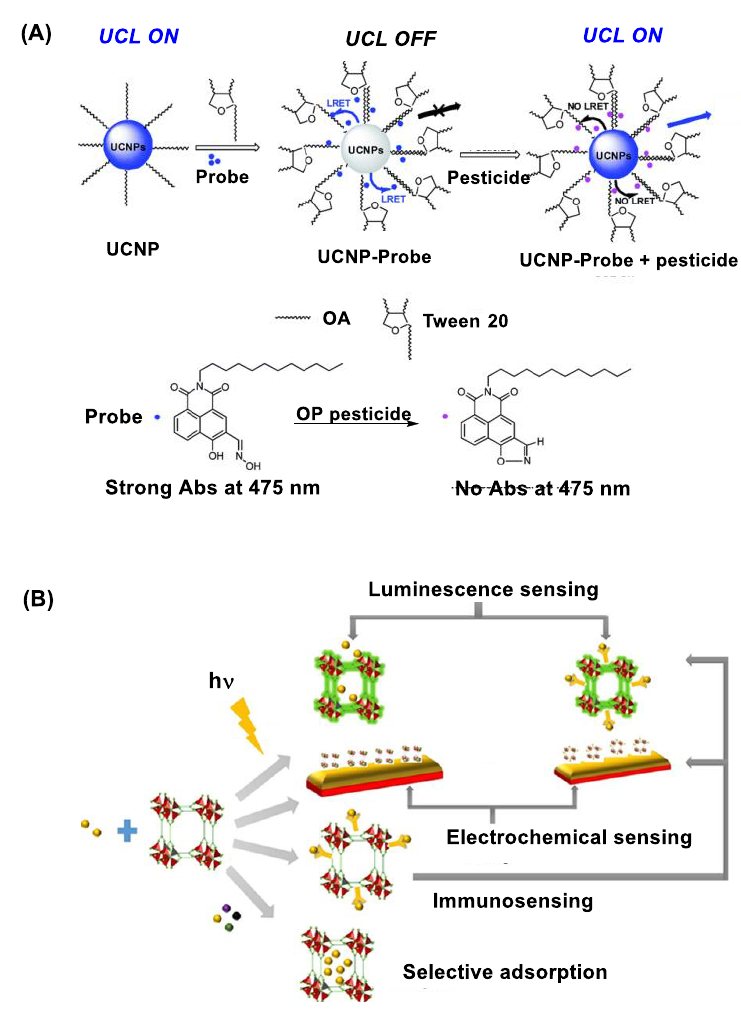
Figure 3. ( A ) Upconversion nanocrystal (UCN) immobilized with an oxime probe on the surface applied for OP detection through the mechanism of luminescence resonance energy transfer (LRET) between UCN and the oxime probe involved in organophosphate detection. Reproduced with permission from [61], Copyright 2016, The Royal Society of Chemistry. ( B ) A schematic diagram for metal-organic framework (MOF)-based approaches developed for pesticide sensing. Reproduced with permission from [72], Copyright 2018, American Chemical